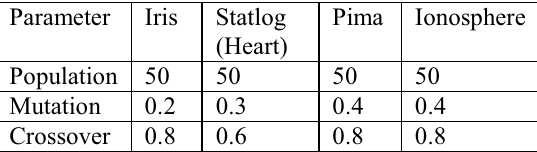
Table 2: Parameters used for simulation